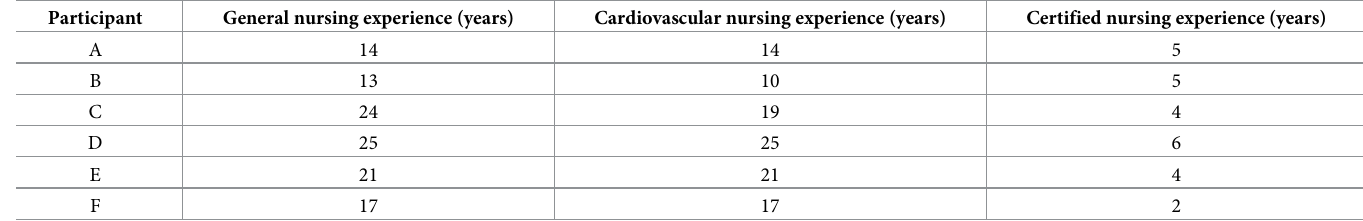
Table 1. Details of the study